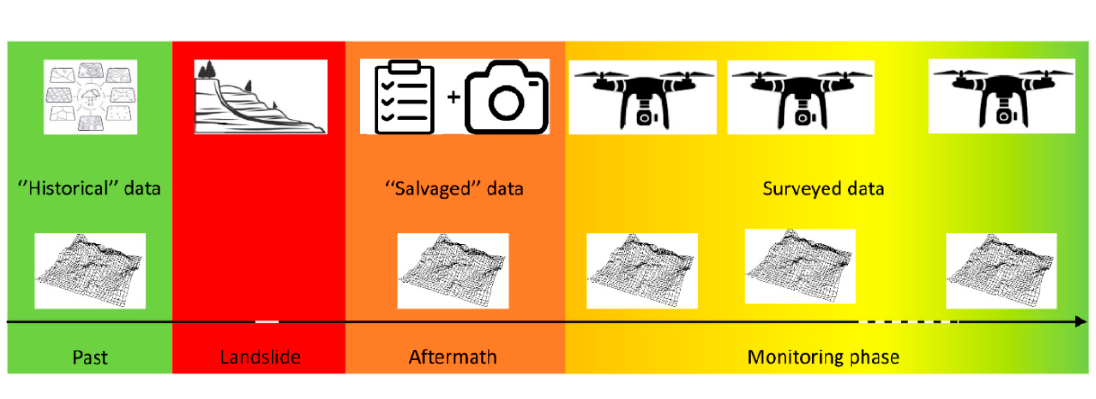
Figure 9. Recapitulatory scheme of the proposed methodology.